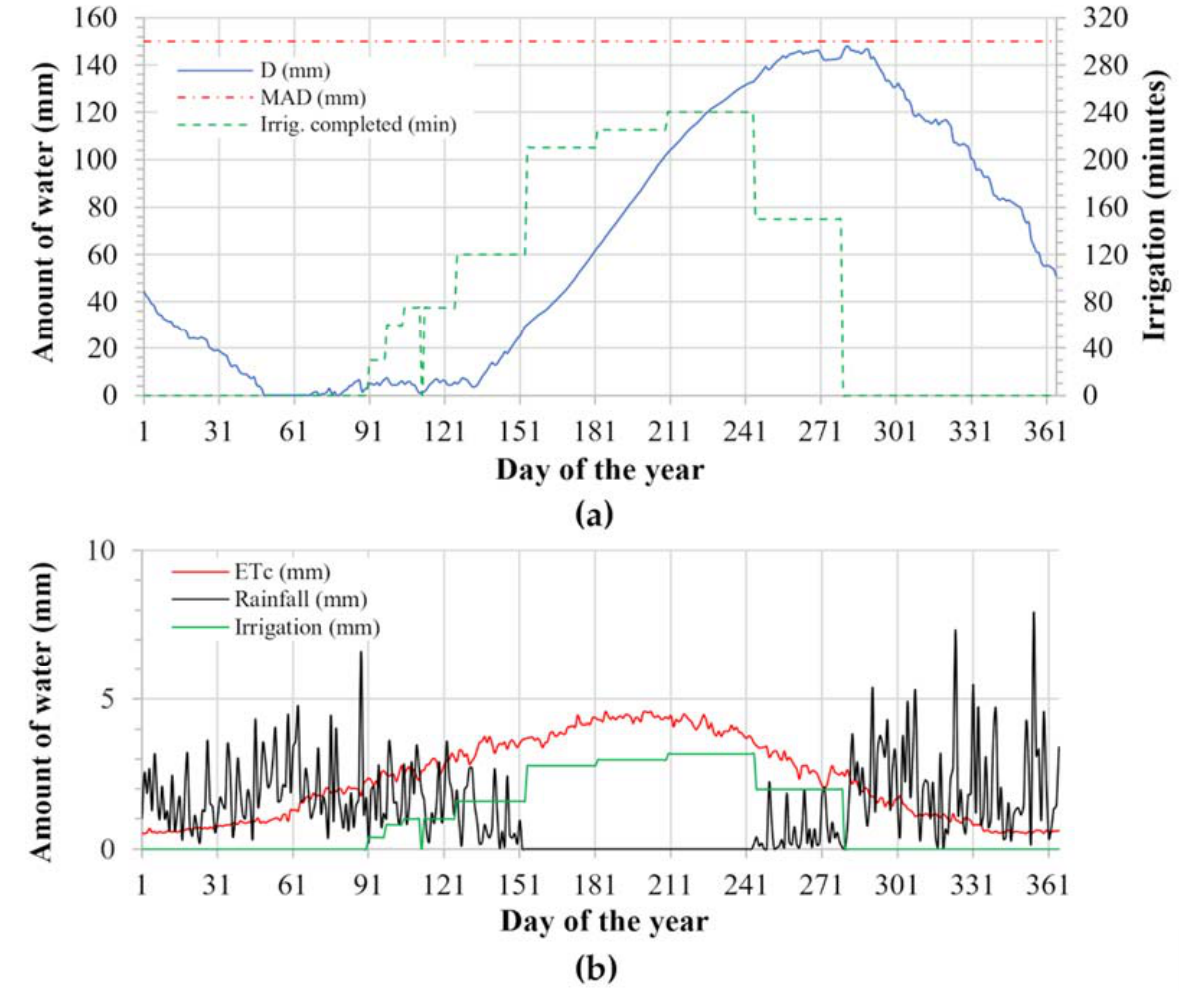
Figure 10. Evolution of the amount of water in the soil for the farm’s irrigation sector 1. Configuration of the photovoltaic system with 8 strings of 20 panels A-315M. In the other three sectors, the evolution is the same. ( a ) Results of the simulation of the evolution of the amount of water in the soil. It looks similar to curve D in Figure 5. ( b ) Soil water inputs and outputs used for the water balance.